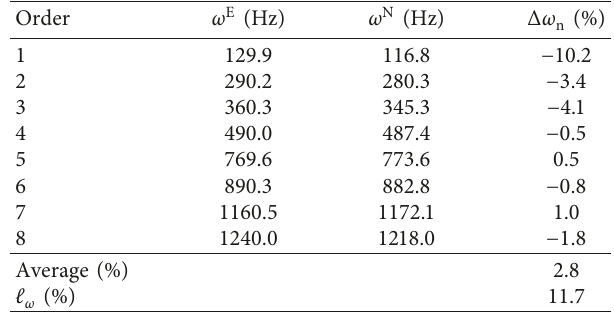
Figure 11: Numerical model of the laminated disk set in black (dashed line) and the experimental FRFs in gray (continuous line) as a reference. Table 2: Comparison between the numerical and experimental natural frequencies of the first eight peaks of the reference point FRF after the adjustment of the laminated disk